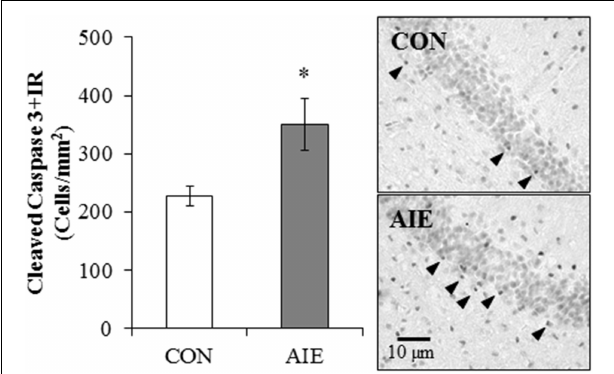
FIGURE 3 | Adolescent intermittent ethanol (AIE) treatment leads to long-term reductions of Ki-67 immunoreactive ( + IR) expression in the young adult hippocampus. Profile cell counts revealed a 35% ( ± 5%) reduction of Ki-67 + IR cells in the dorsal hippocampal dentate gyrus of AIE-treated animals on postnatal day 80, relative to controls (CONs). Data are presented as mean ± SEM. ∗∗ indicates p < 0 . 01, relative to CON rats. Included are representative photomicrographs of Ki-67 + IR cells in the dentate gyrus of the dorsal hippocampus from CON- and AIE-treated animals. Arrowheads highlight Ki-67 + IR cells.